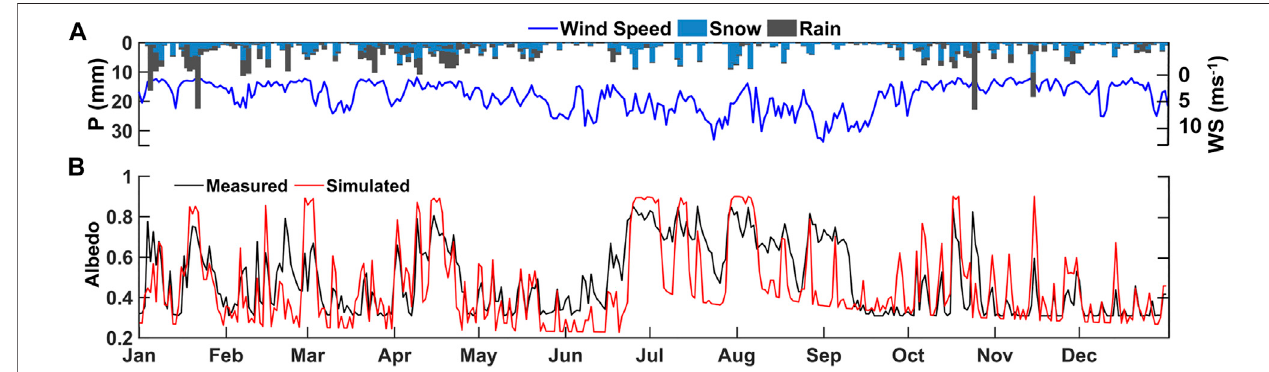
FIGURE5|(A) Dailysnowandrainvaluesaccumulatedfrom30-minprecipitationatP8.SnowfallfractionwasdiscriminatedaccordingtoPSOschemedepending ontemperature ranges(See Section3.1.2 ).Dailywind speedvalues(blueline)measured inSAMA-1wereincluded forcomparison purposes. (B) Comparisonbetween dailyalbedomeasuredatSAMA-1station(blackline)andsimulatedaftersettingparameters(redline).Dailyvalueswerecomputedinthedaytimebetween10:00and16: 00 h local time.